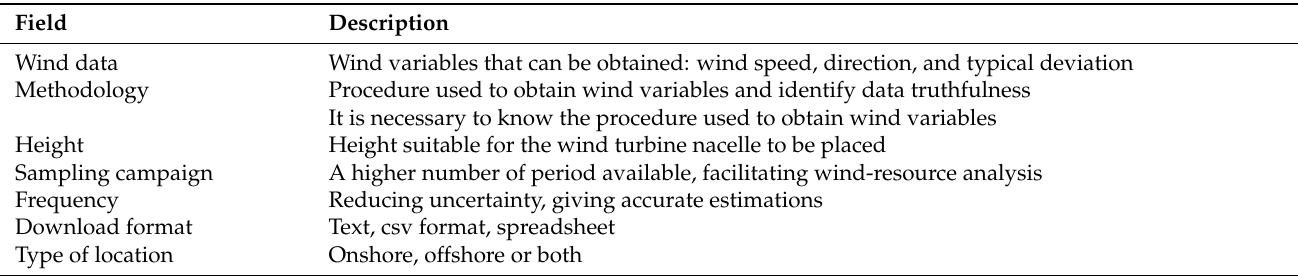
Table 1. Knowledge database.